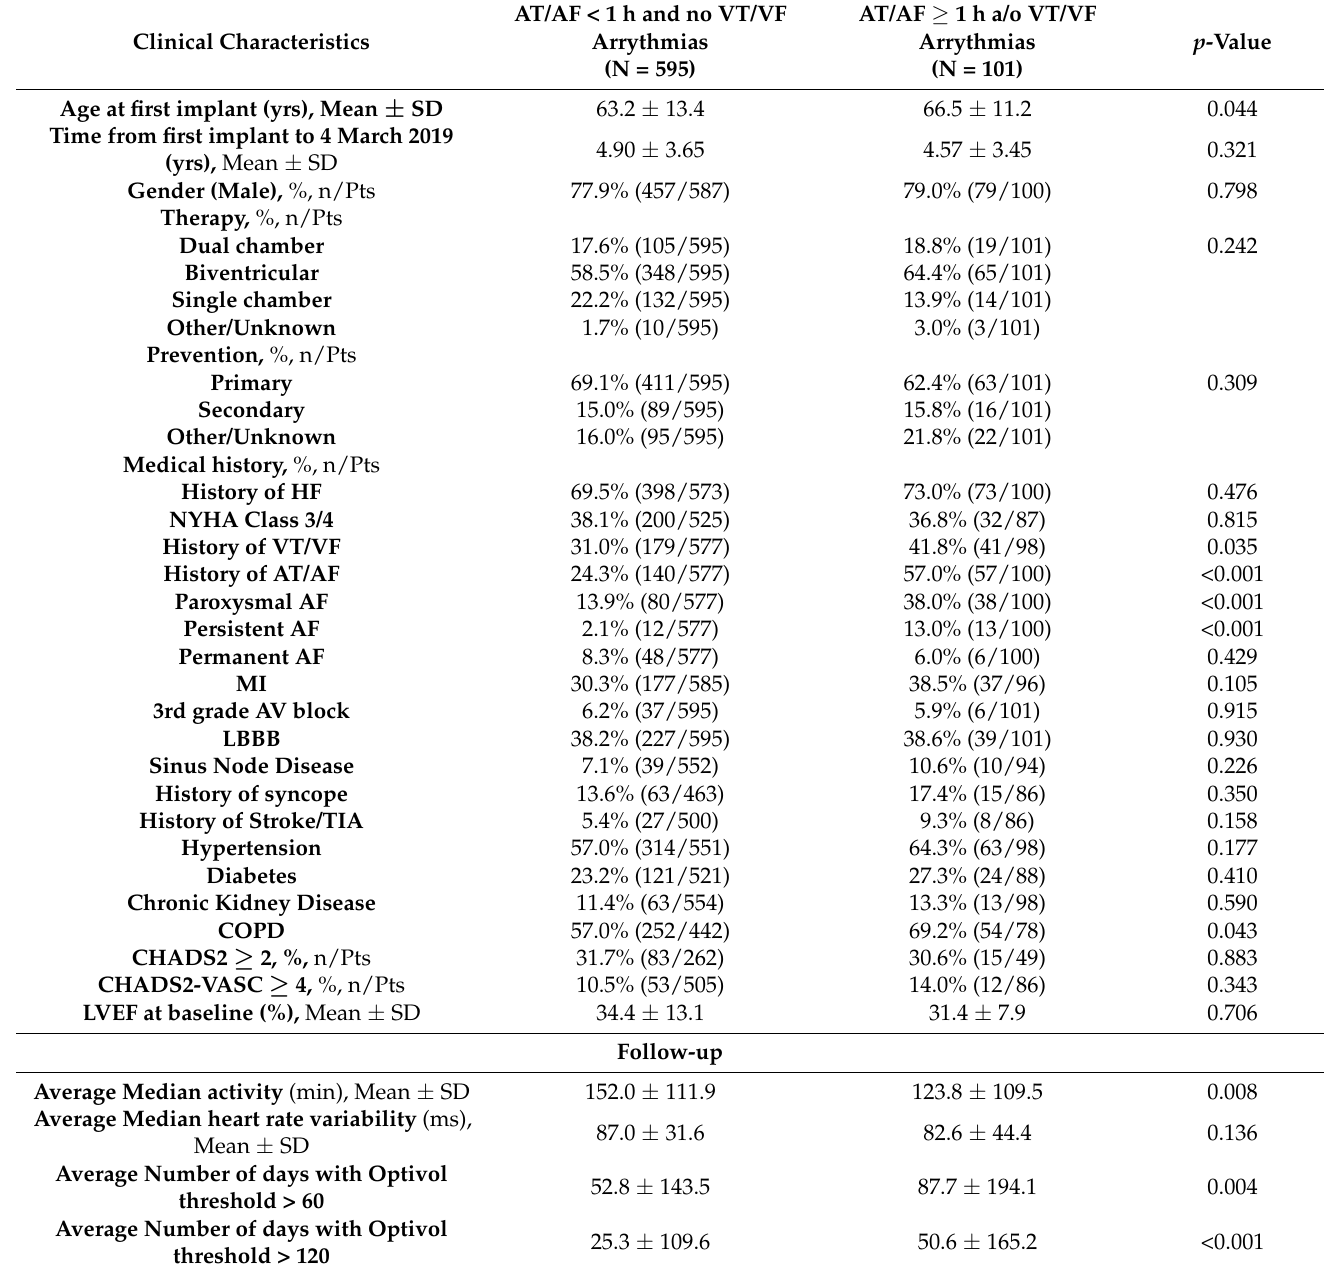
Table 2. Baseline clinical characteristics and follow-up parameters in patients with vs. without AT/AF and/or VT/VF during lockdown